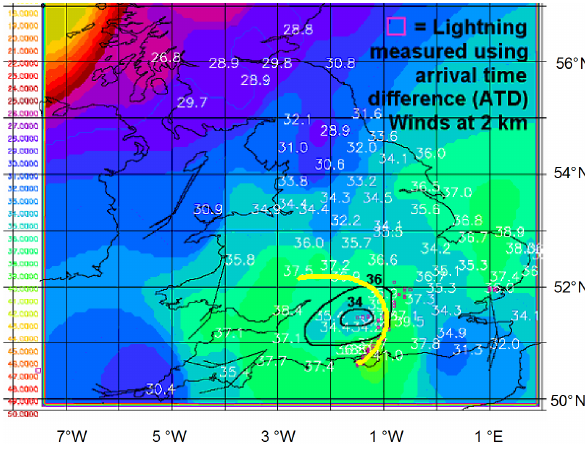
Fig. 6. GPS integrated water vapour processed by the Met Of- fice/University of Nottingham system, 24 June 2005, 14:00UTC. Contours give values of IWV in kgm − 2 . Linkenholt is located at the edge of the lightning location at the centre of the 34kgm − 2 con- touring. The yellow band indicates the arc of weather radar echo that seems to be associated with the band of lightning in the